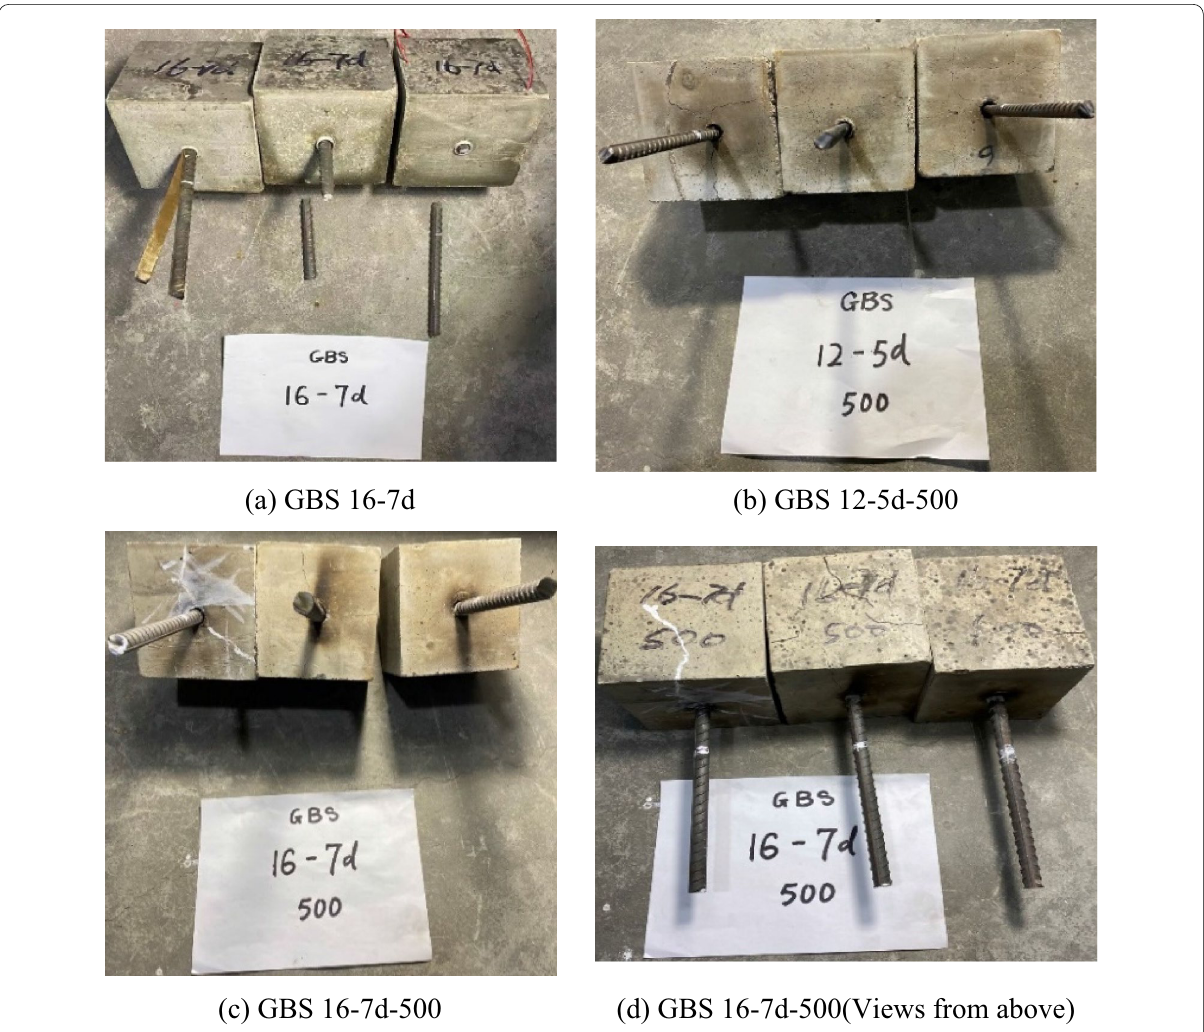
Fig. 7 Types of failure